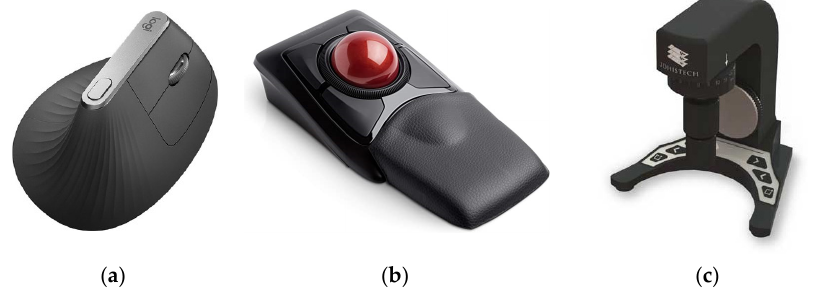
Figure 6. Ergonomic devices: ( a ) Logitech MX Vertical Ergonomic Wireless Mouse; ( b ) Kensington Expert Mouse Wireless Trackball ® ; ( c ) SlideDriver.